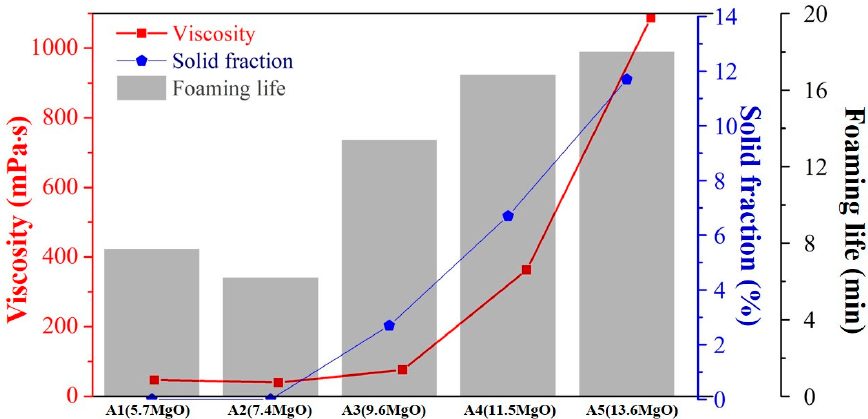
Figure 9. Influence of MgO content on the viscosity, foaming life, and solid fraction.